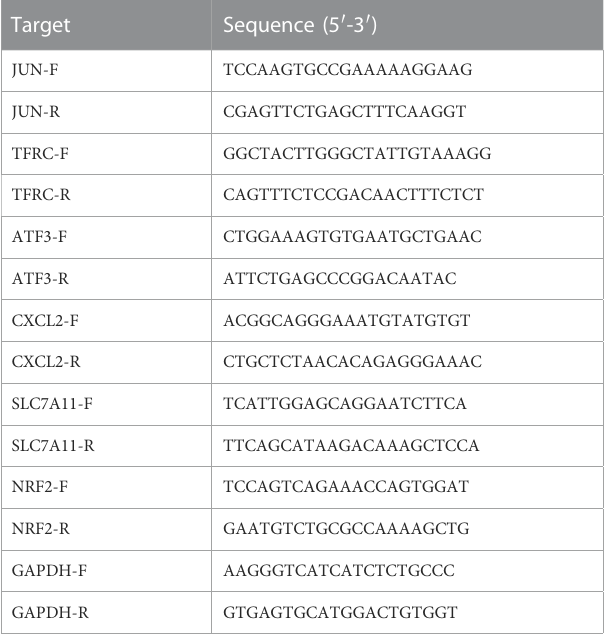
TABLE 1 The primers used for quantitative real-time PCR